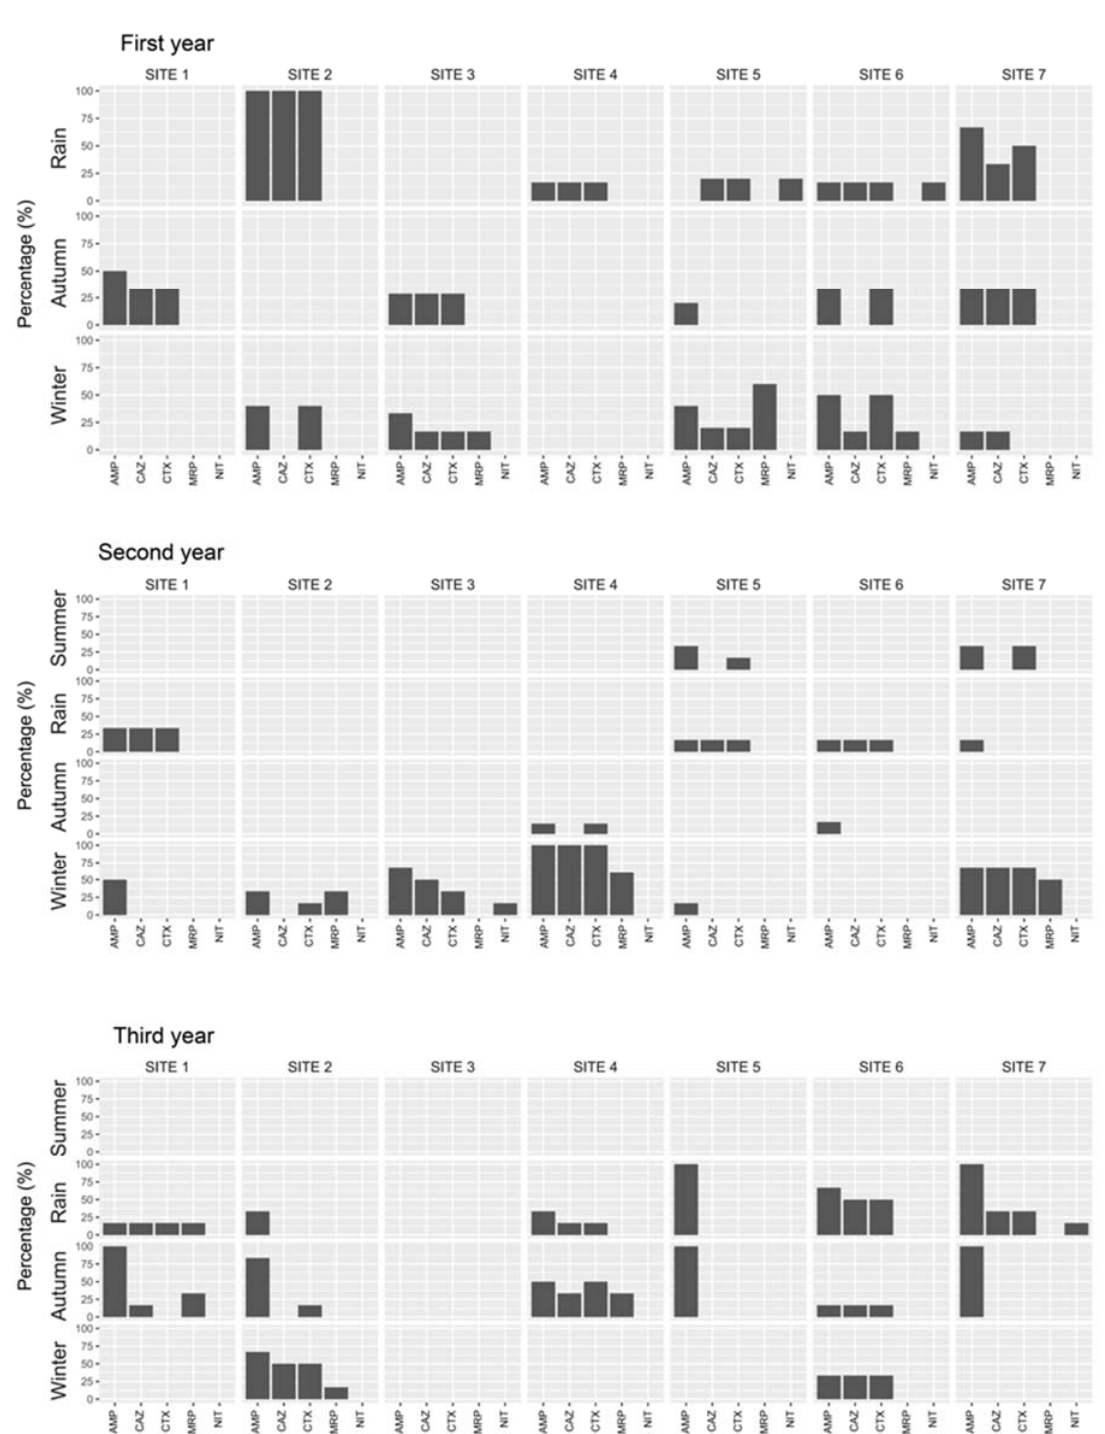
Figure 4. Antibiotic resistance patterns in E. coli isolated from sediment samples of the Kshipra river in India in various seasons and at various sites over a 3 ‐ year period. Abbreviations: AMP: Ampicillin, CAZ: Ceftazidime, CTX: Cefotaxime, MRP: Meropenem, NIT: Nitrofurantoin. Note: significant ( p < 0.05) seasonal and spatial variations in the resistance of E. coli to ampicillin, ceftazidime, cefotaxime, meropenem, and nitrofurantoin were found over the 3 ‐ year period. Information for all antibiotics is available in Table S6.